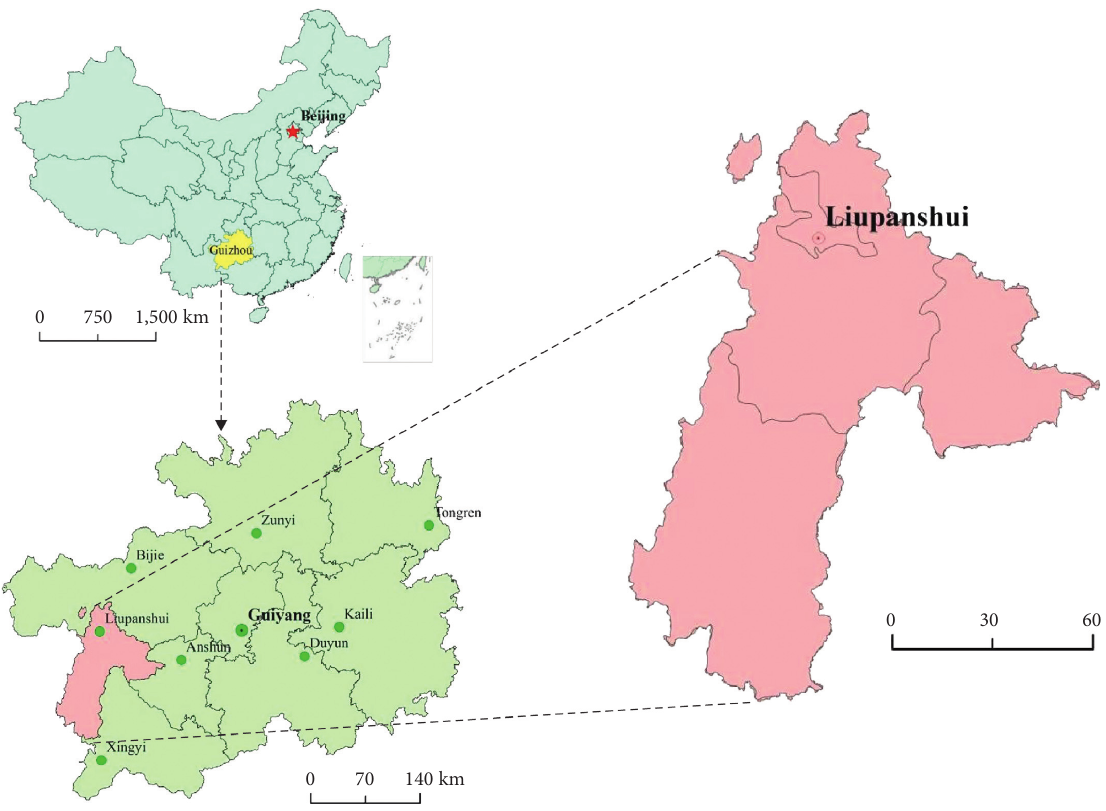
Figure 1: The location of the study